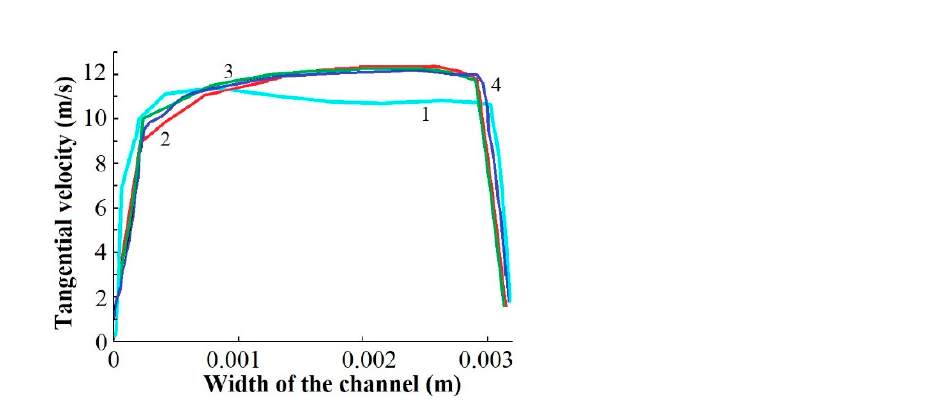
Figure 15. Distribution of tangential velocity u y ; reference lines for different channel lengths (1–4): 1— l chan = 0 (inlet), 2— l chan = 0.007 (m), 3— l chan = 0.014 (m); 4— l chan = 0.021 (m).